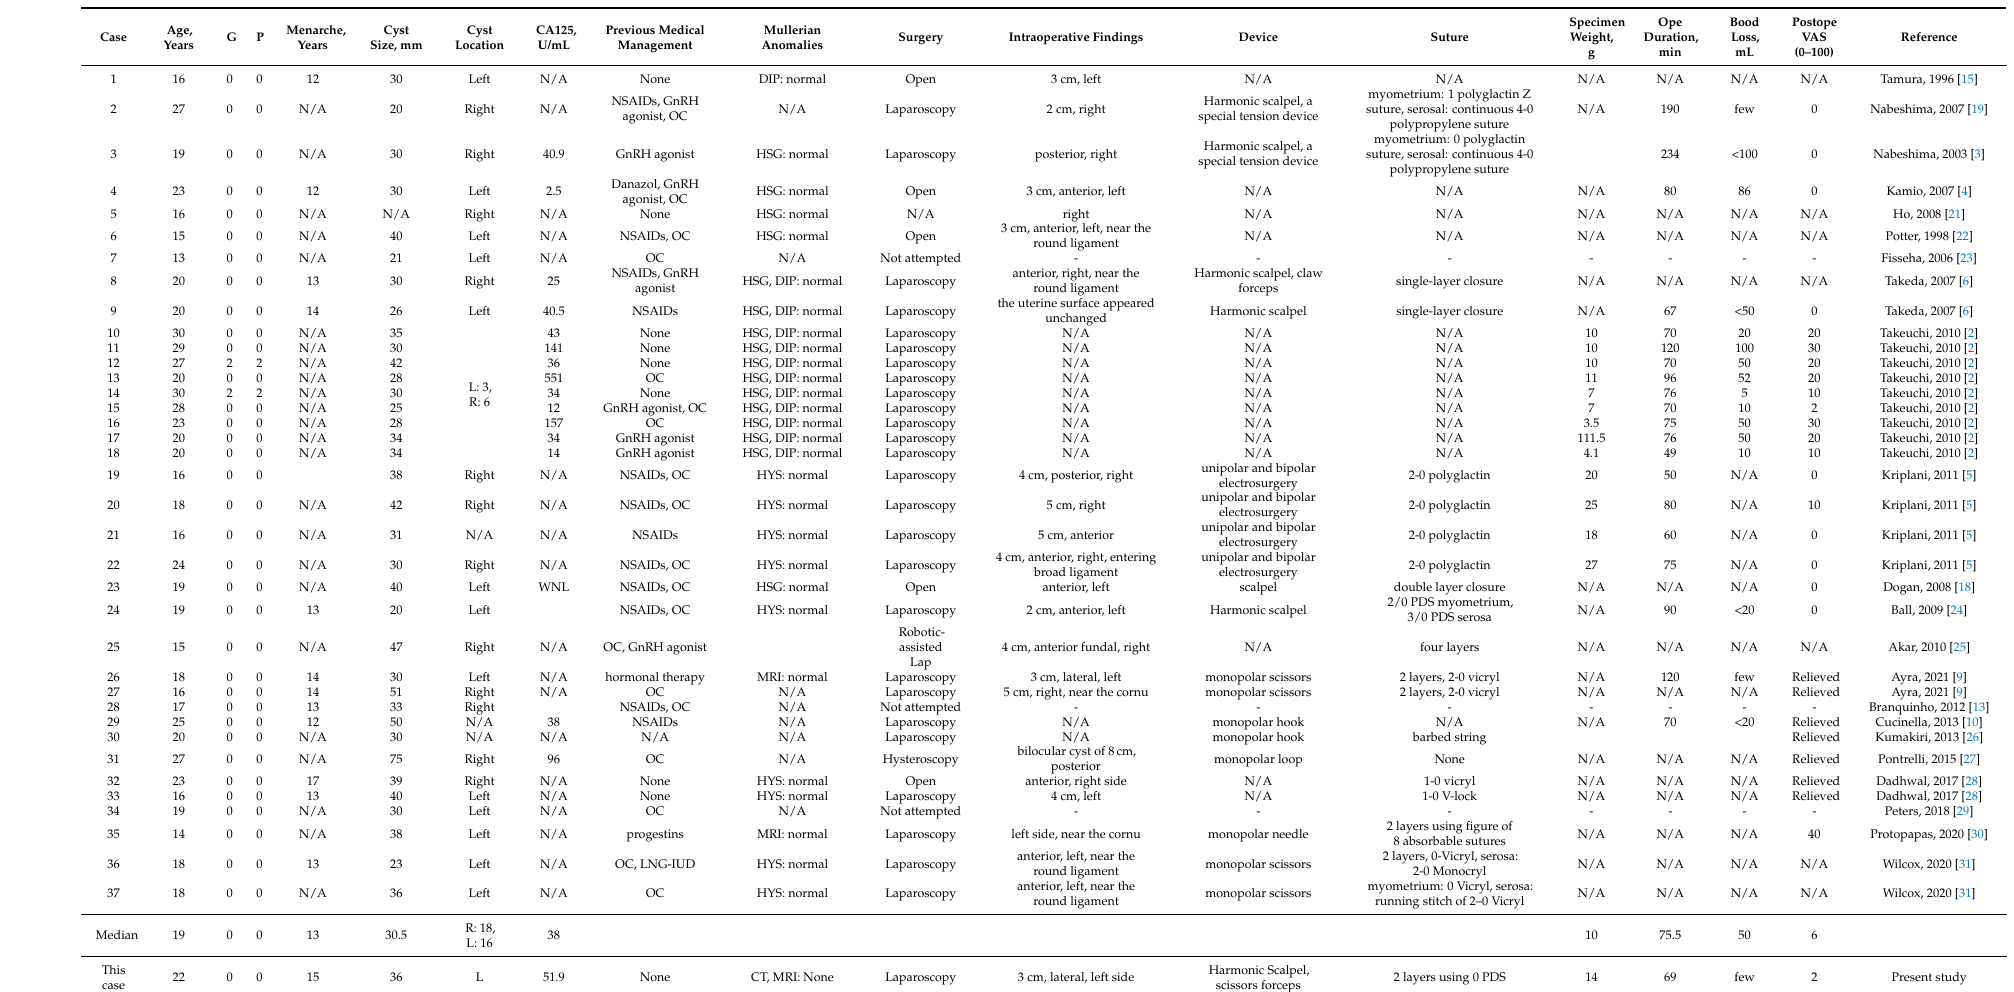
Table 1. 22 reports of surgical treatment for juvenile cystic